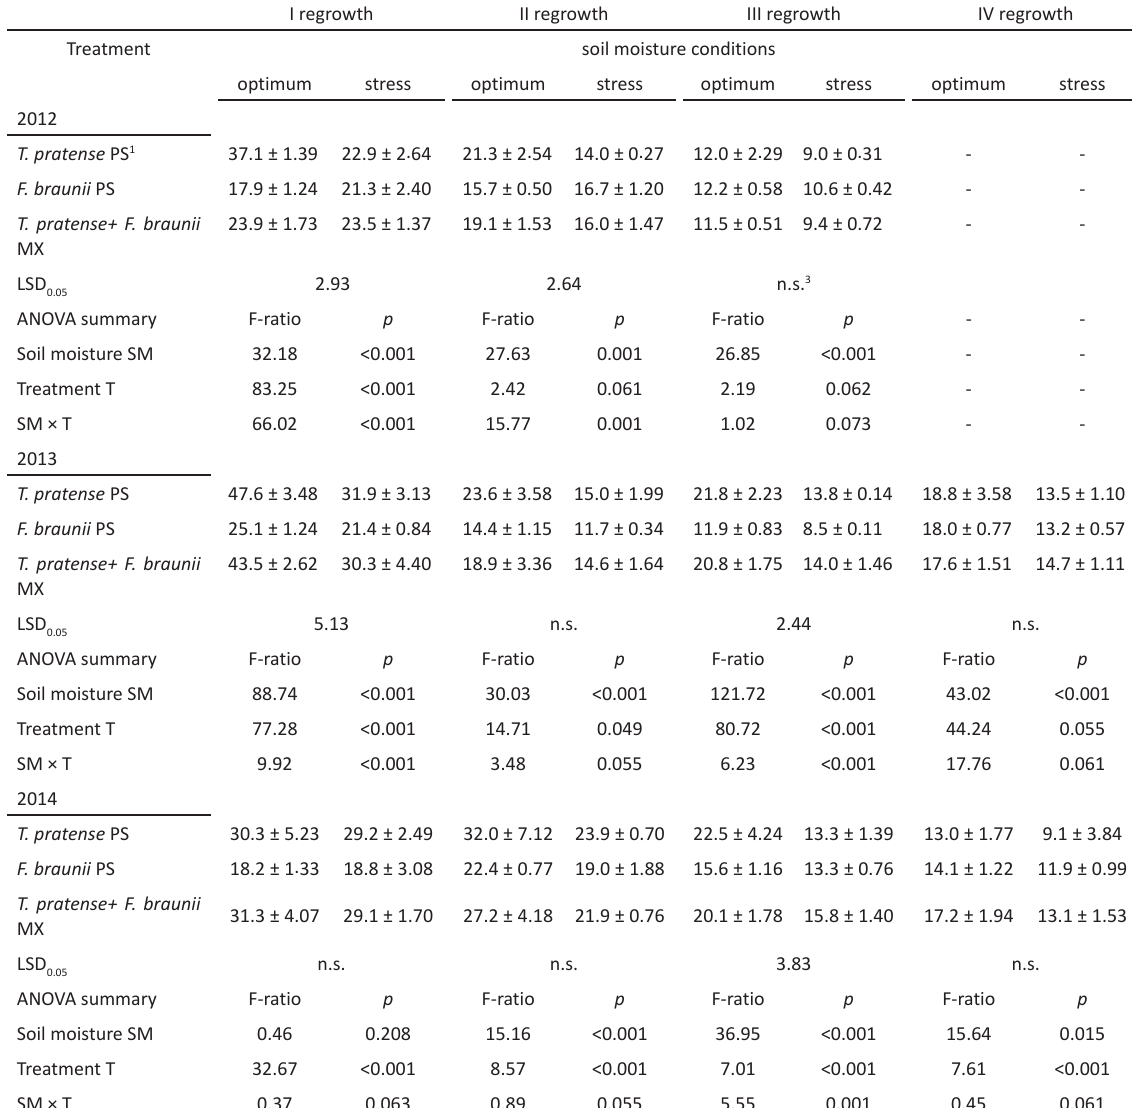
Table 1. Dry matter yield (DMY) of Trifolium pratense and Festulolium braunii grown in pure stand (PS) and in mixture (MX) under optimal and drought stress conditions (g pot -1